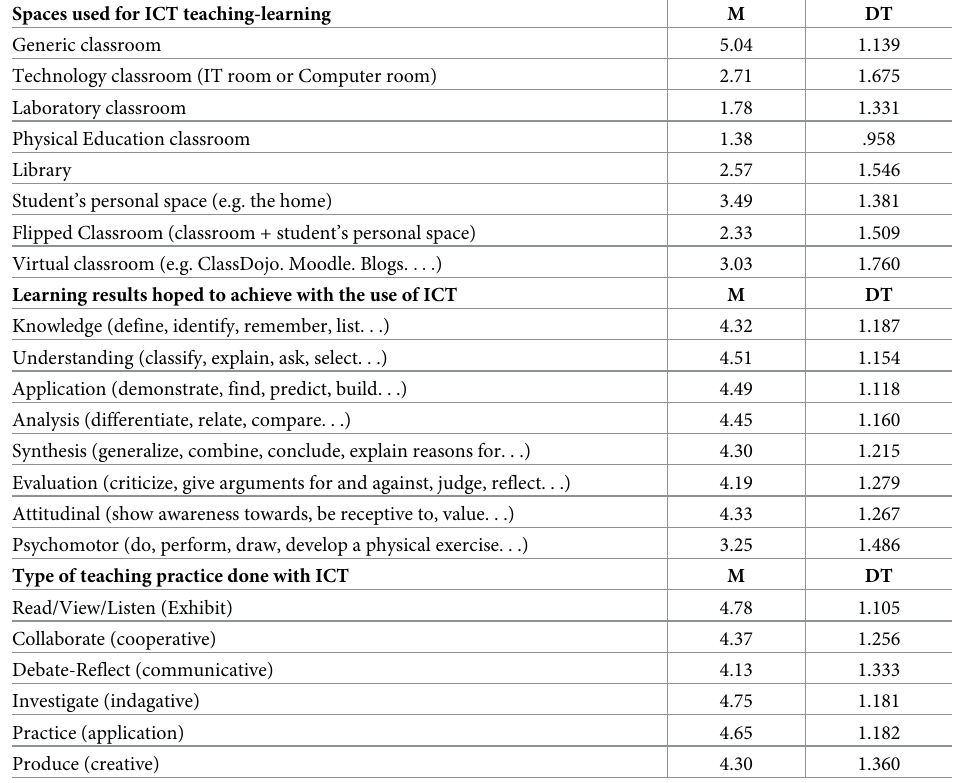
Table 1. Description of the usual teaching practices with ICT: Spaces, learning results and typology. Spaces used for ICT teaching-learning M DT Generic classroom